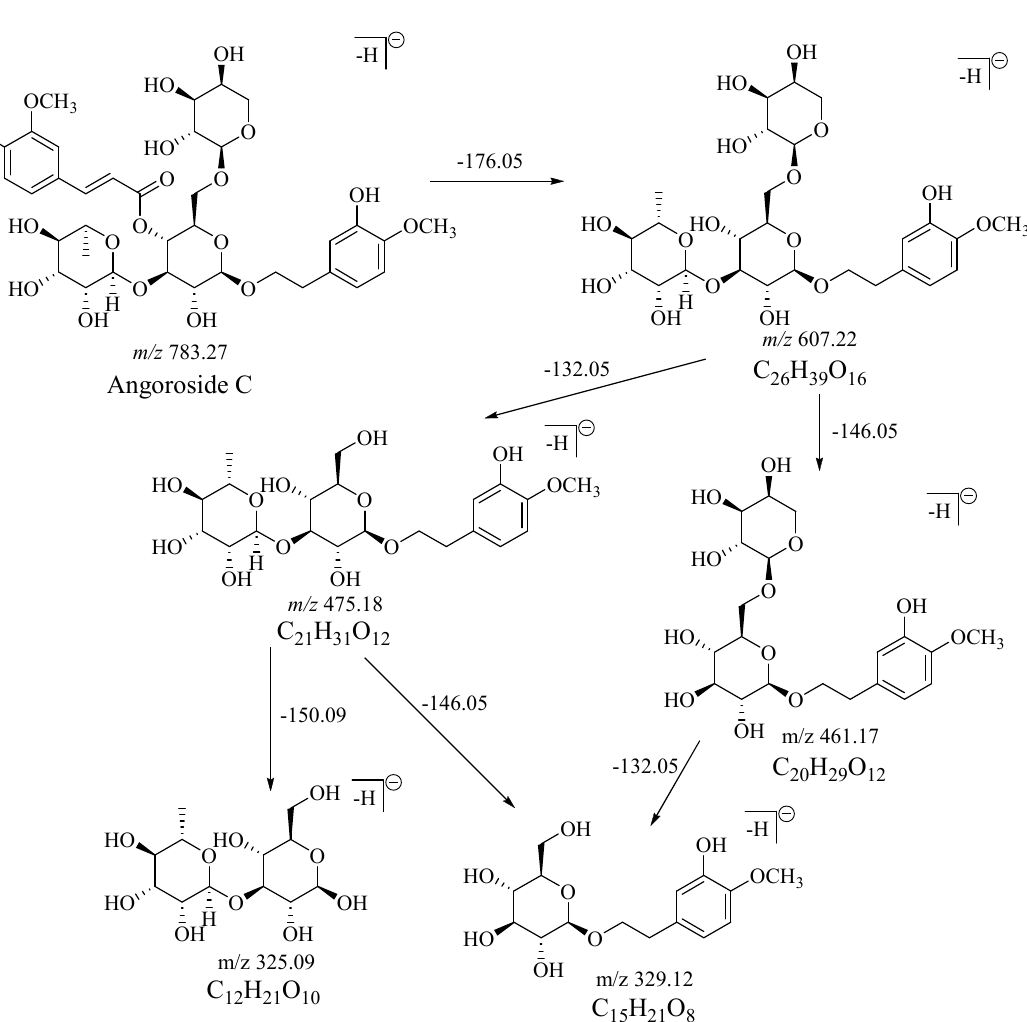
Figure 2. The fragmentation processes of angoroside C.